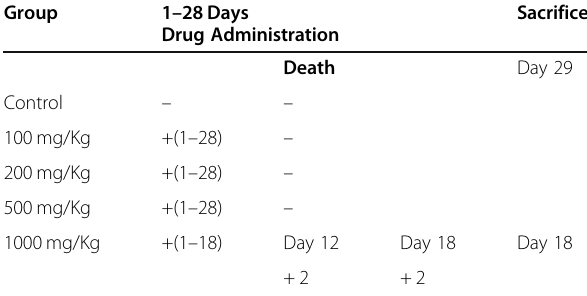
Table 1 Chronic Toxicity Experimental Timeline and